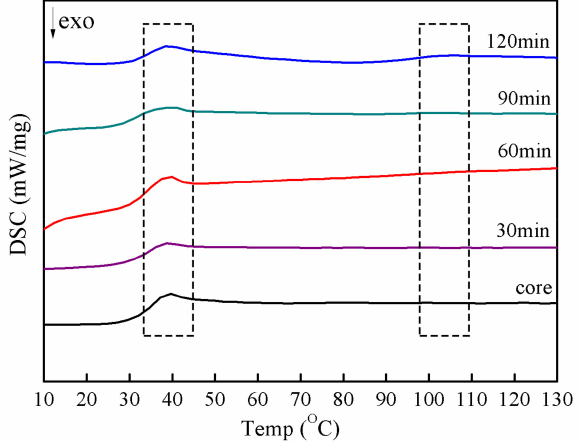
Figure 5. DSC curves of the composite emulsions with different shell polymerization